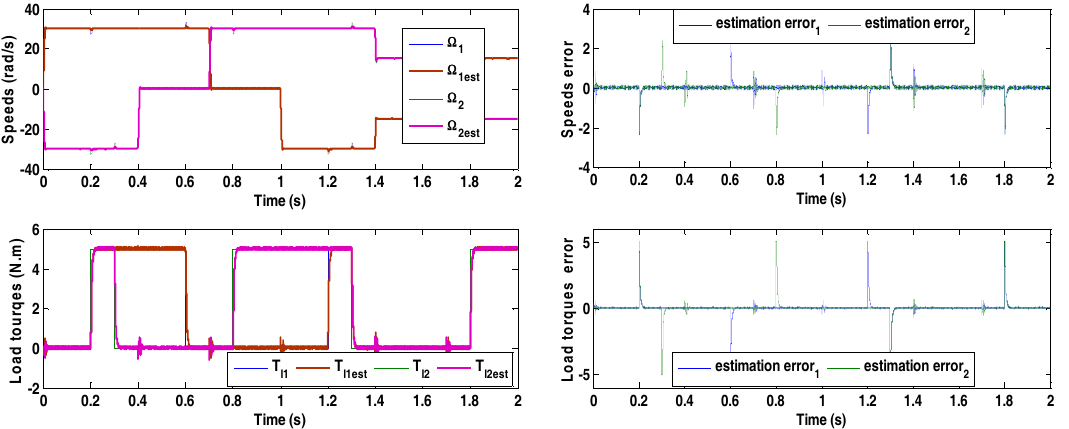
Figure 10. Dynamic responses of parallel-connected two five-phase PMSMs system at different loading conditions.